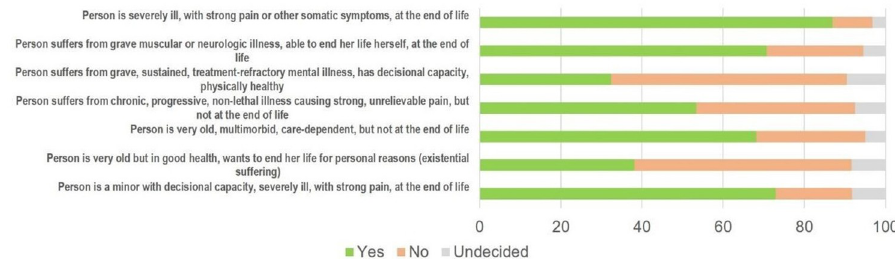
Fig 2. Attitudes of health care professionals towards the legitimacy of assisted suicide in different patient populations.